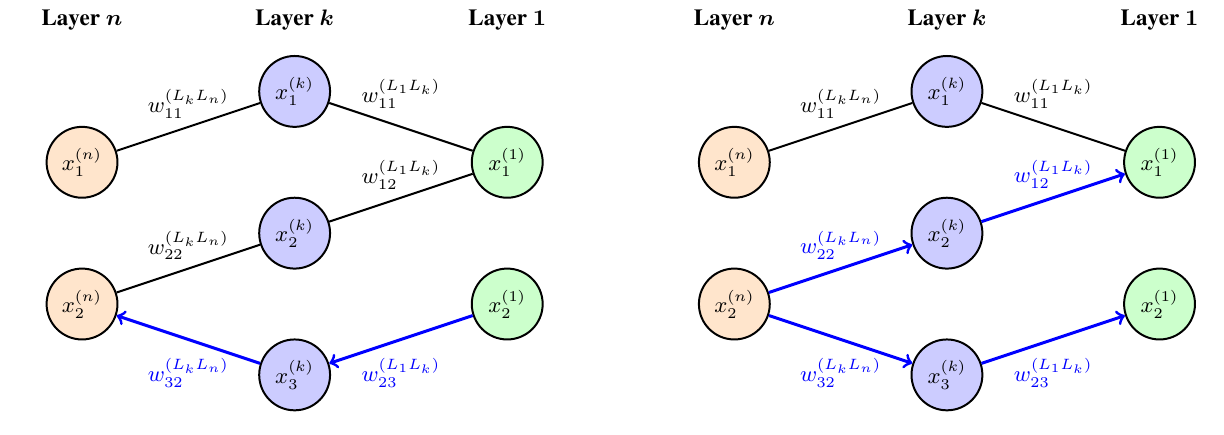
Figure 2. An example of a bidirectional Path-tracing Semantic Network (PSN), where x ( k ) L k and w ( L k 1 L k 2 ) indicates the weight of edge connecting vertices v ( k 1 ) ij